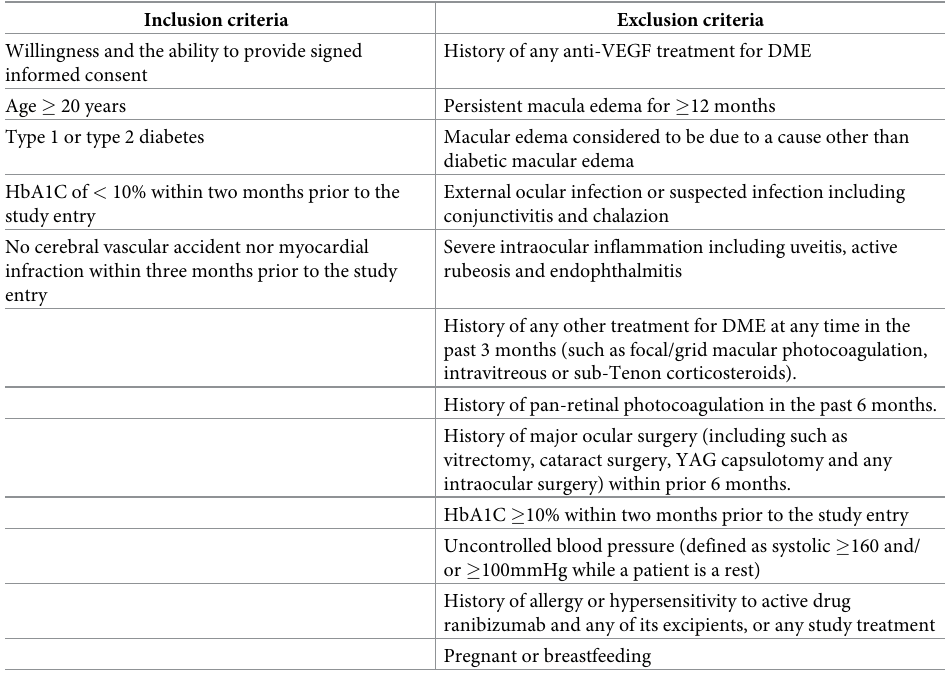
Table 1. Inclusion and exclusion